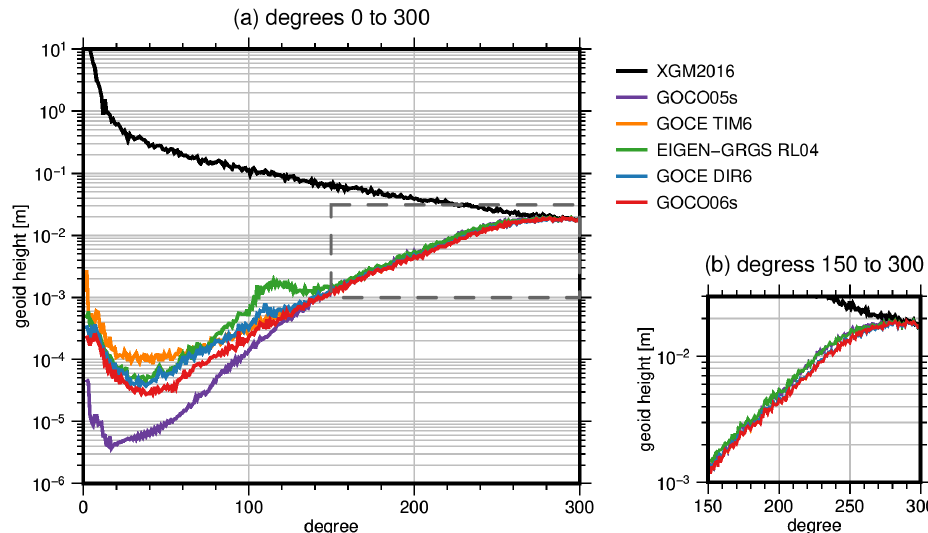
Figure 8. Difference degree amplitudes of various state-of-the-art satellite-only models compared to the combined model XGM2016 (polar cap with 8 ◦ aperture angle excluded). Panel (a) shows the whole spherical harmonic spectrum covered by the models, while panel (b) only shows degrees 150 to 300.